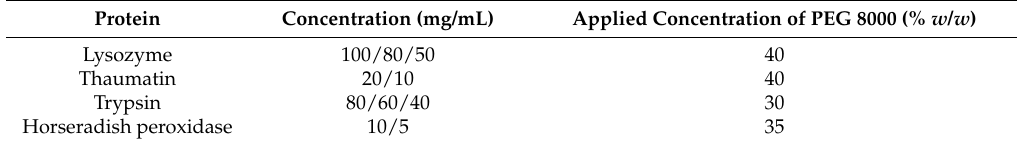
Figure 5. Probability of successful crystallization trials under different protein concentrations using the double emulsion-based approach to implement the vapor diffusion method and microbatch method for: ( a ) Lysozyme; ( b ) Thaumatin; ( c ) Trypsin; ( d ) Horseradish peroxidase. Table 1. The applied concentration of PEG 8000 in the continuous phase with different protein solutions. Protein Concentration (mg/mL) Applied Concentration of PEG 8000 (% w / w ) Lysozyme 100/80/50